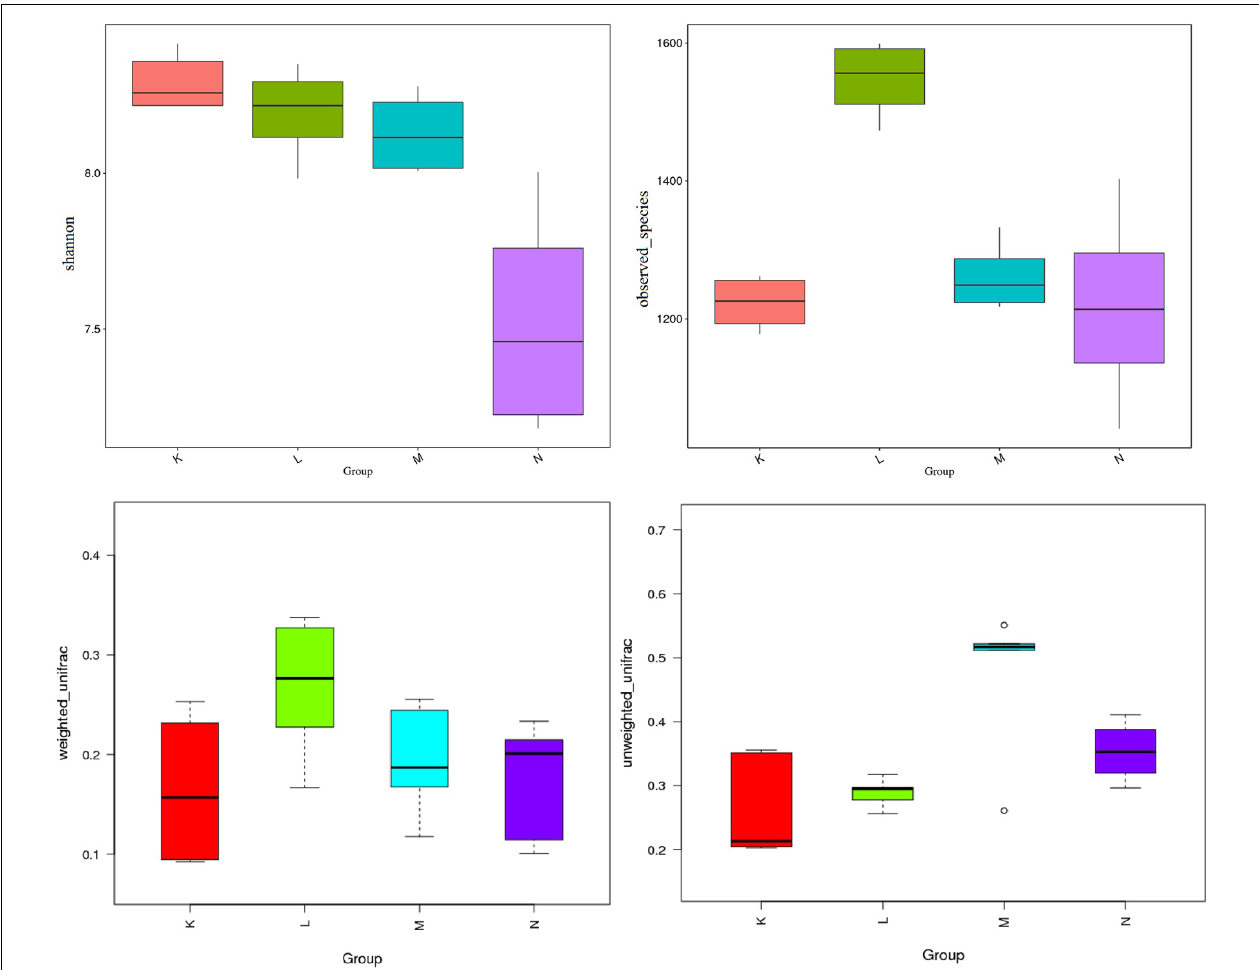
FIGURE 5 | Comparisons for alpha-diversity (Shannon and observed species index) and beta-diversity (with weighted and unweighted Unifrac distance matrix) of fecal the microbiota of between the low- and high-altitude groups of sheep. K, low-altitude mouflon; L, high-altitude mouflon; M, low-altitude blue sheep; N, high-altitude blue sheep.